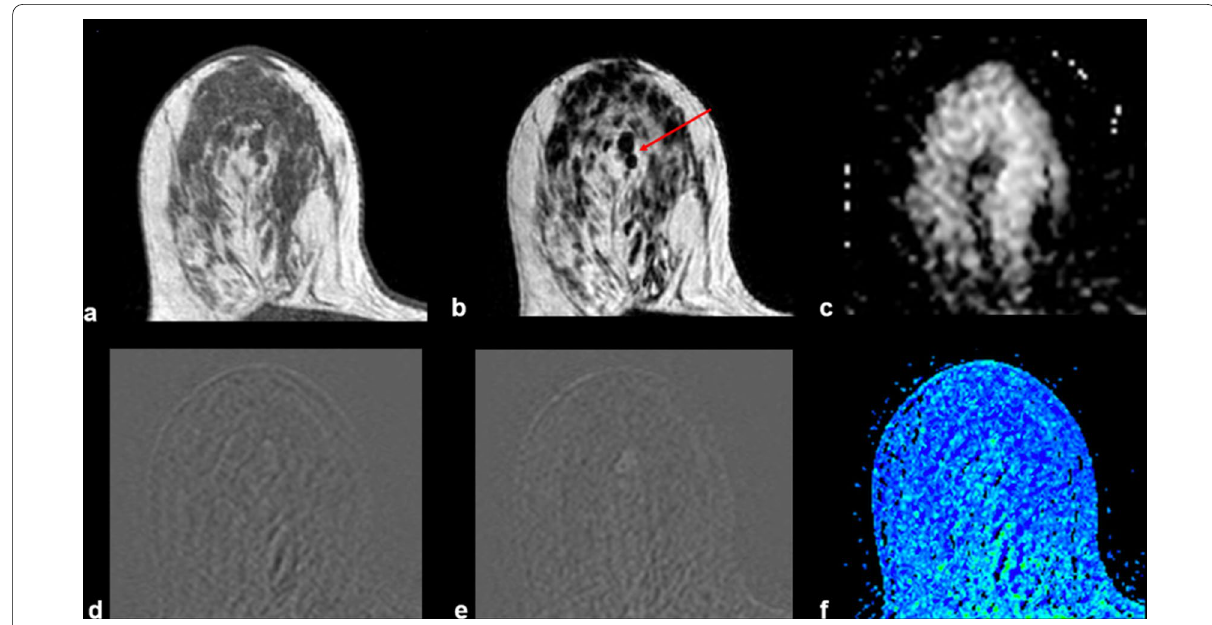
Fig. 2 Example of MRI findings of a previous BIRADS 3 examination. A 63‑year‑old patient underwent follow‑up of a periareolar solid nodule of 15 6 mm in the right breast classified as BIRADS 3 by previous examinations. Top: T1‑W axial ( a ), T2 VISTA axial ( b ) and ADC map ( c ), which show a × bilobed hypointense nodule in the union of the upper quadrants of the right breast with no restricted diffusivity. T1‑W sequence shows a scattered glandular tissue classified as ACR D, occupying the four quadrants. Bottom: initial postcontrast subtraction ( d ) without enhancement and delayed subtraction ( e ) showing slight enhancement at the nodule location, which corresponds to the kinetic response described by the wash‑in map ( f ). Thus, it was assigned BIRADS